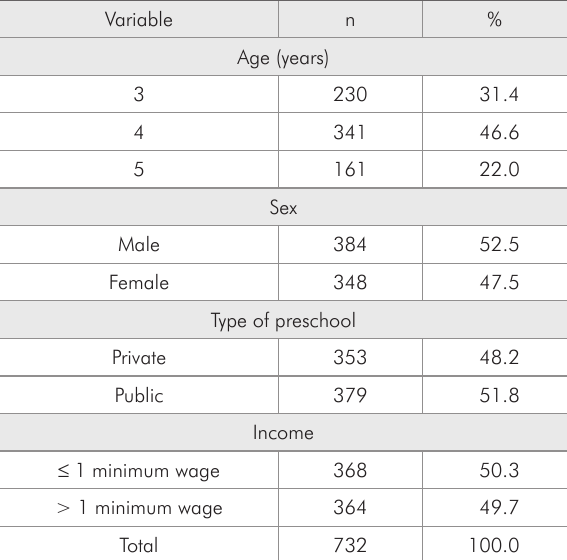
Table 2 - Sample characteristics related to socioeconomic